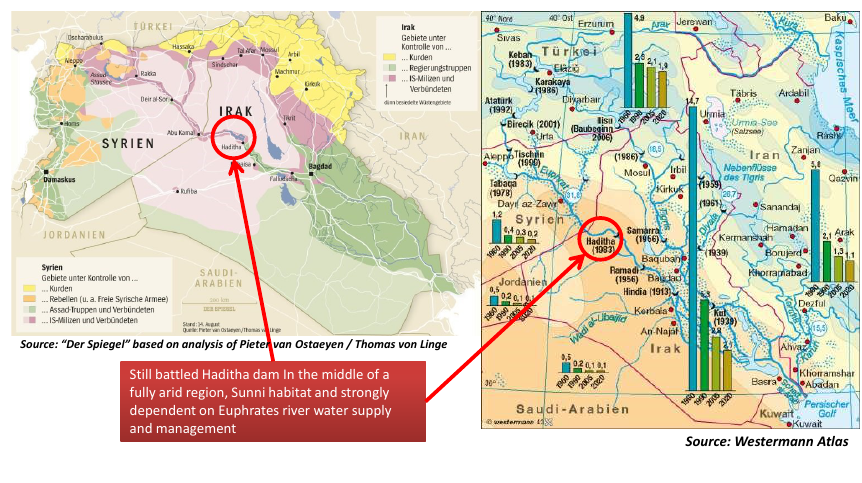
Figure 5. GPCC’s climatological data sets are utilized as reference material (right panel, here Westermann Atlas) and potentially help to comprehensively understand water modulated conflicts (left panel) and to serve independent reference information for water diplomacy.